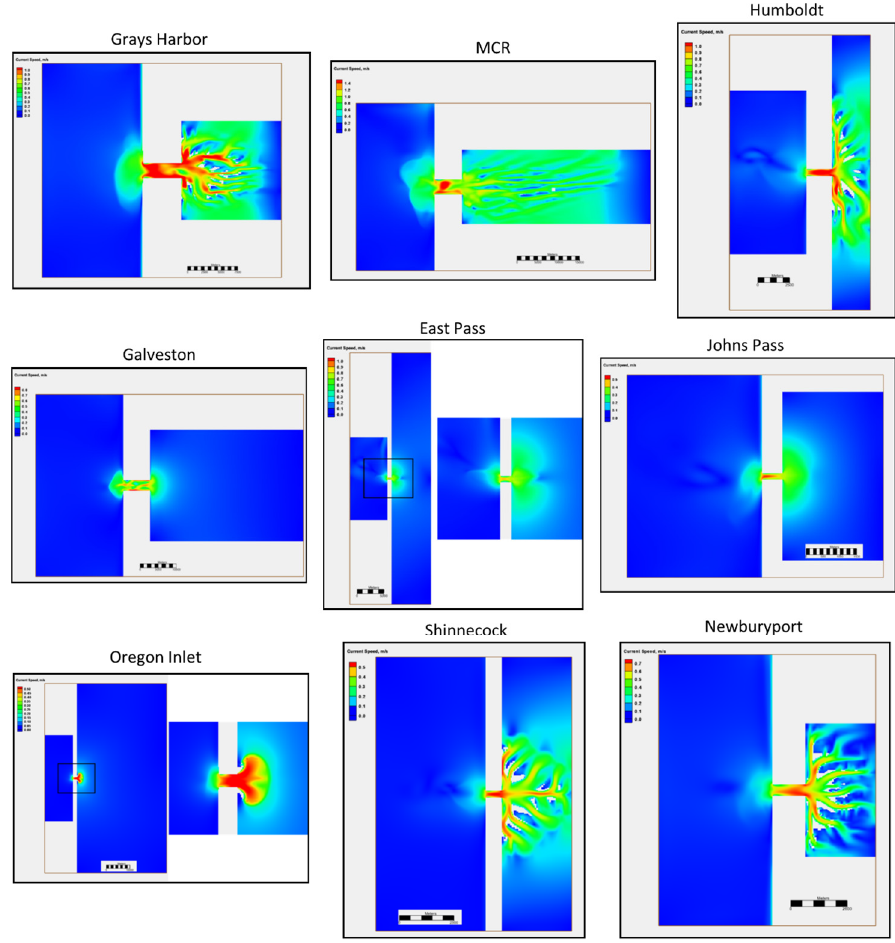
Figure 8. Maximum flood currents near the end of the simulation. For clarity, the color scale varies between inlets. White areas shown inside the bays denote areas that were considered dry (above the water level) at the time chosen for the plot.